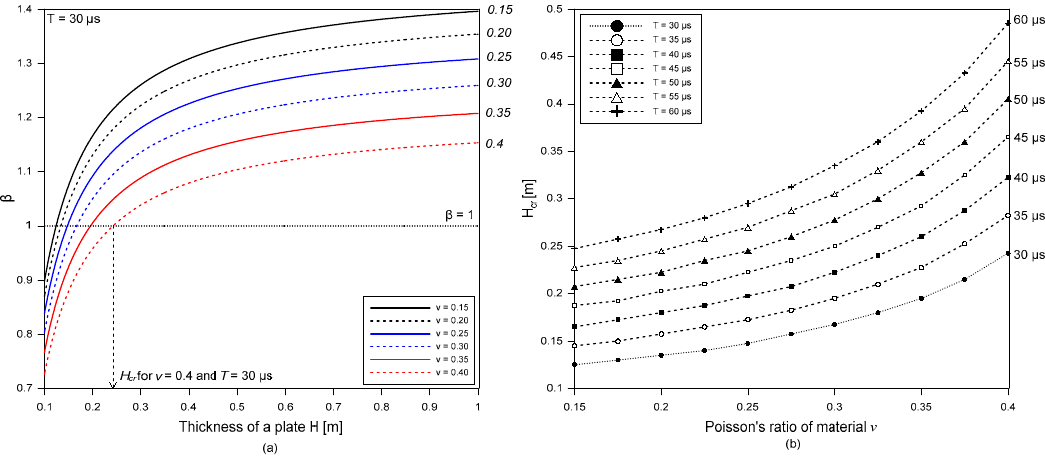
Figure 7. ( a ) Variation of minimum value of ß in Equation (13) with respect to the thickness of a plate, H , and Poisson’s ratio, v and ( b ) variation of critical thickness, H cr , with respect to Poisson’s ratio, v , and duration of incident waves, T . and duration of incident waves, T .